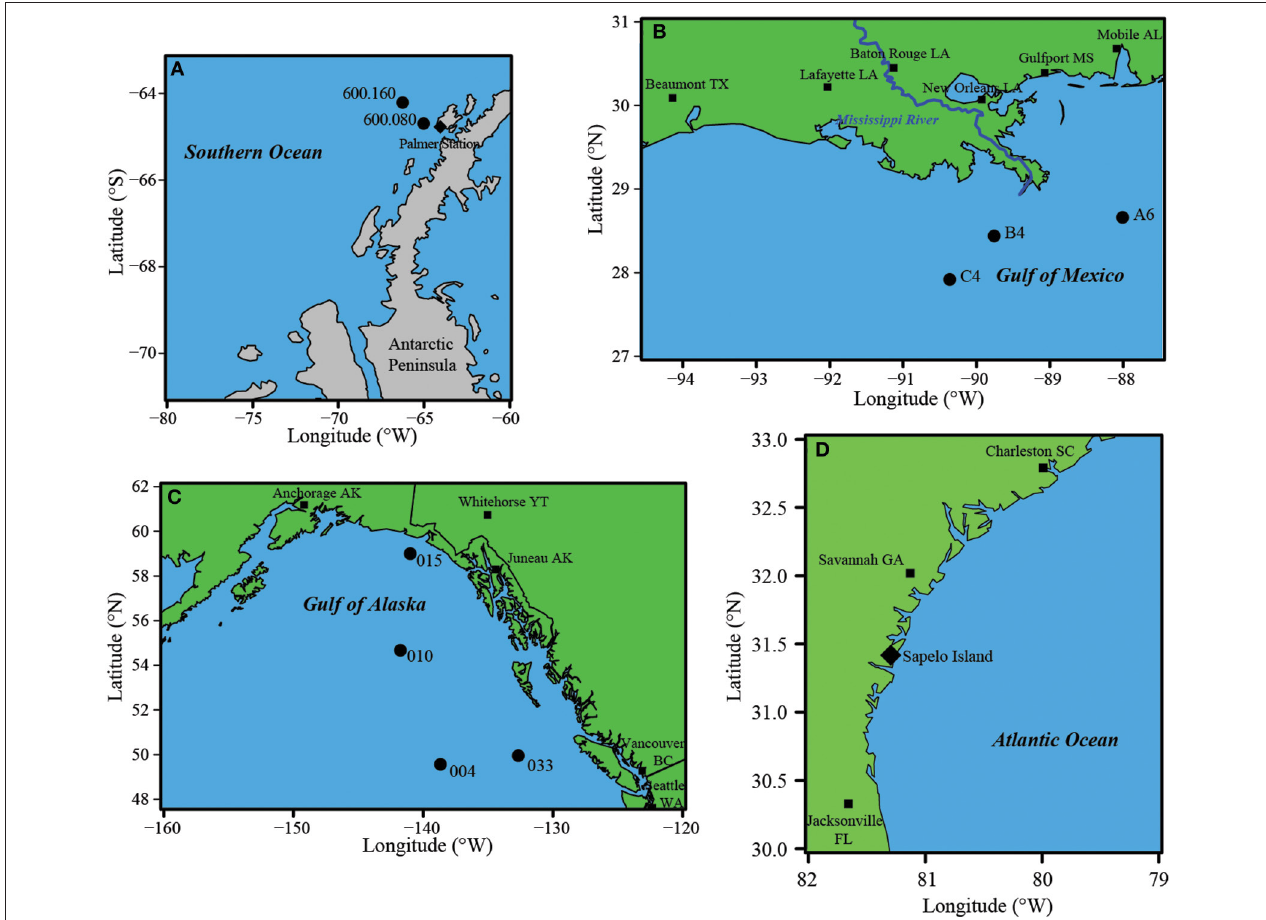
FIGURE 2 | Locations of sample sites where H 2 O 2 experiments were performed. (A) Southern Ocean west of the Antarctic Peninsula; (B) Gulf of Mexico; (C) Gulf of Alaska, (D) Marsh Landing on Sapelo Island,